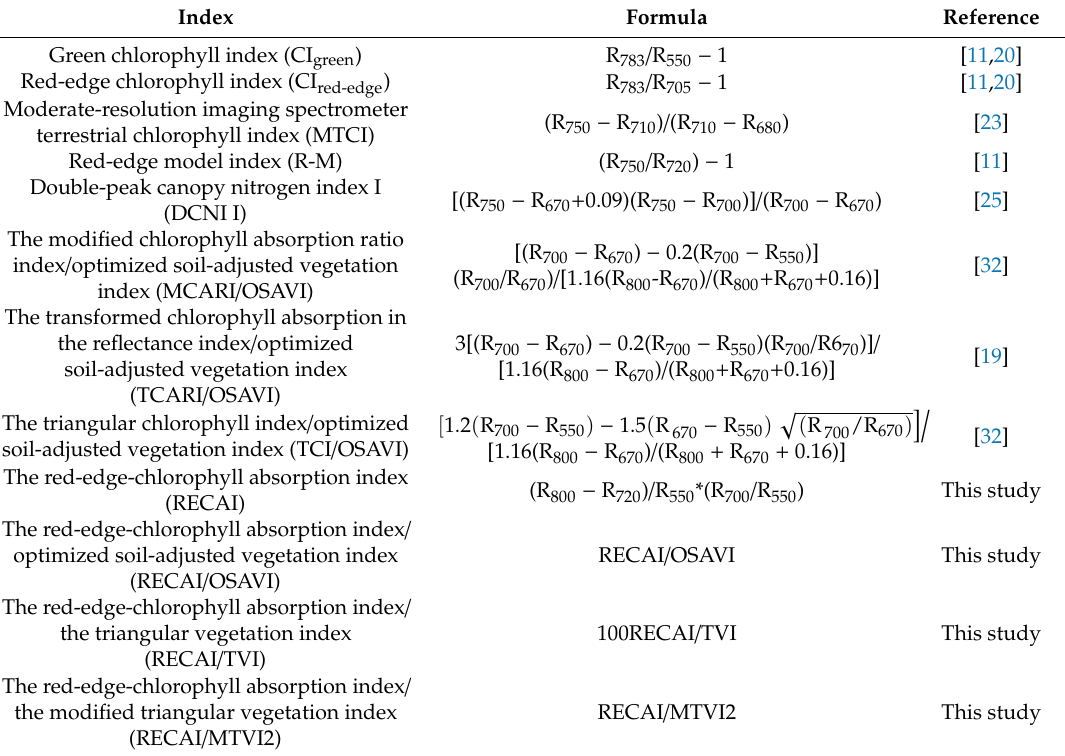
Table 4. Spectral indices used in this